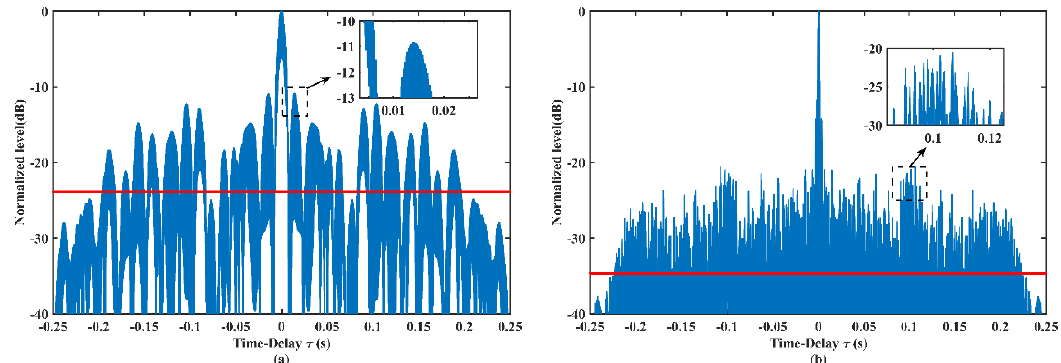
Figure 7. Autocorrelations of ( a ) the initial GSFM pulse and ( b ) the optimized GSFM pulse. Their parameters are same as Figure 2a and Figure 5a, respectively. The solid red lines represent the average sidelobe levels.